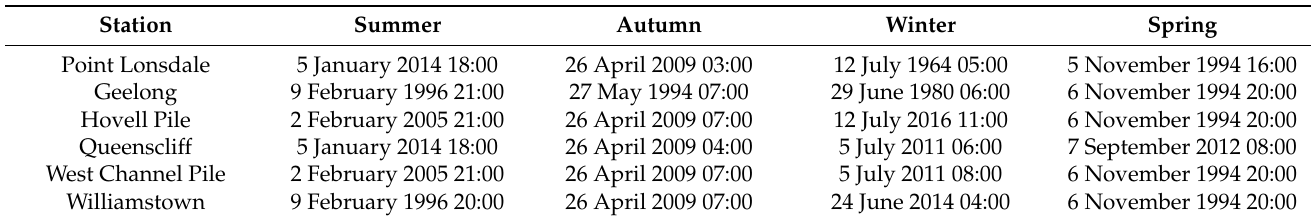
Table 2. Timing of largest “hourly water levels” at tidal gauges in PPB for different seasons.